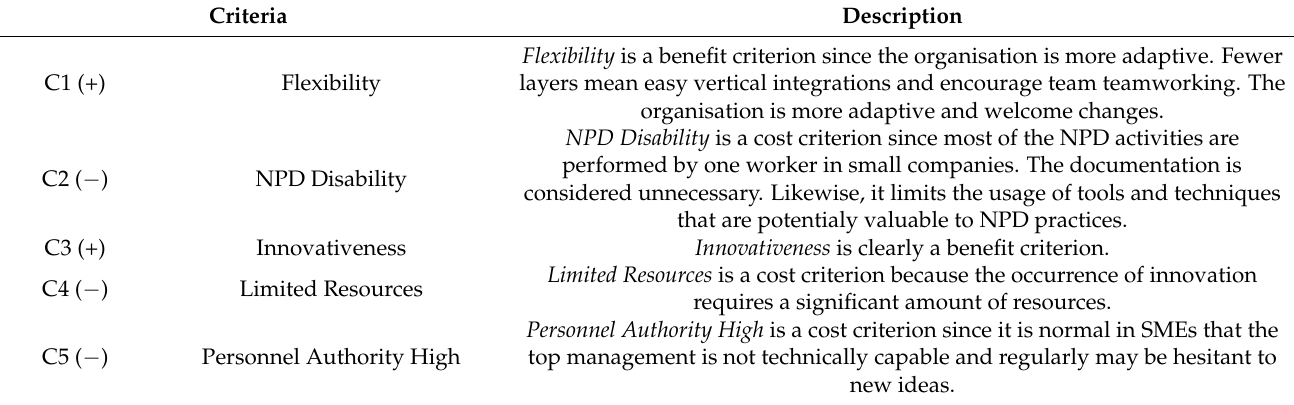
Table 1. Criteria and